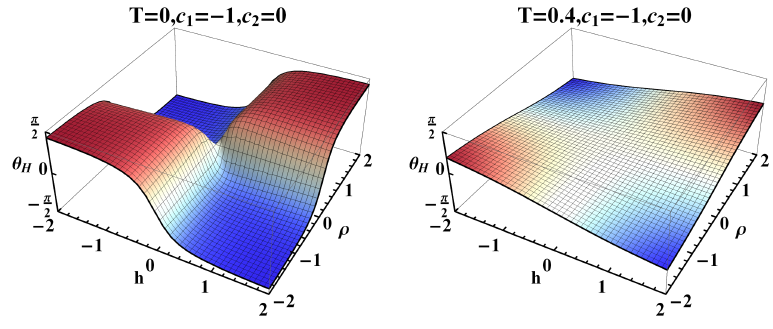
Figure 7 . Hall angel at T = 0 (left panel) and T = 0 . 4 (right panel). c 1 = − 1 and c 2 = 0